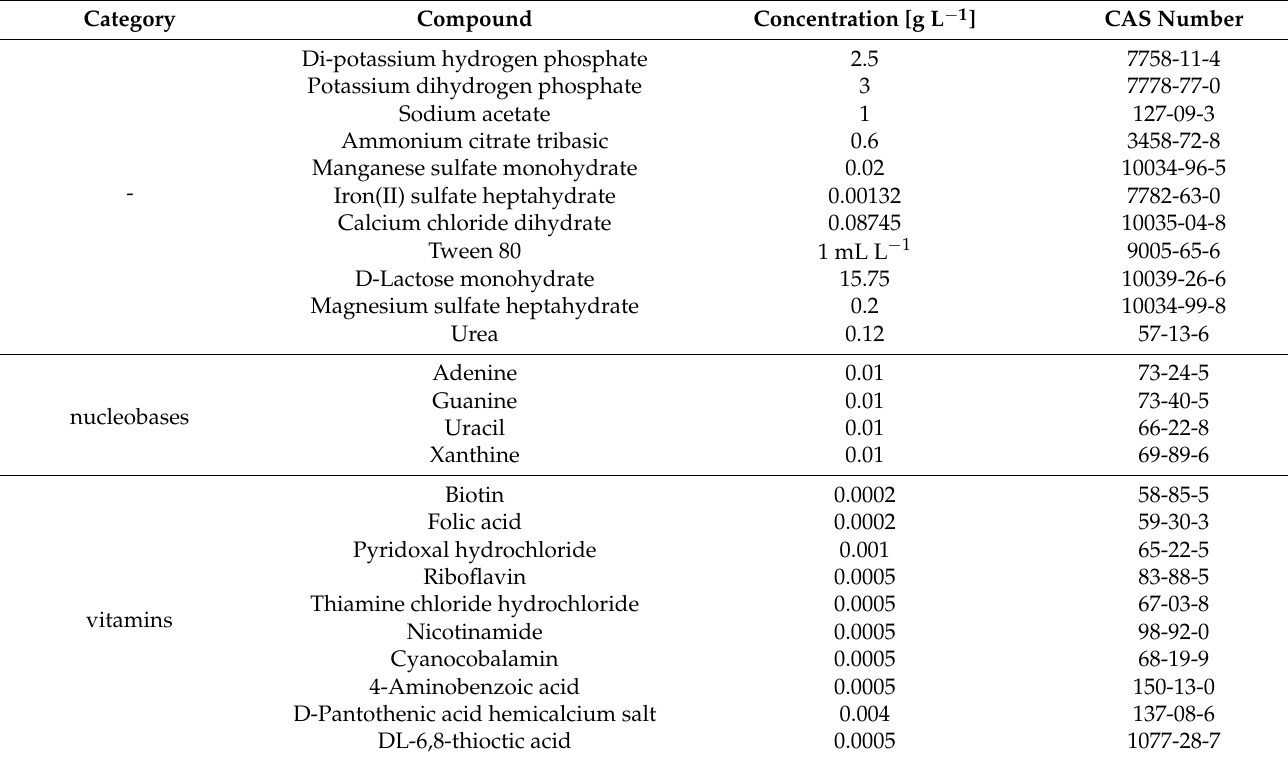
Table 1. Composition of synthetic medium